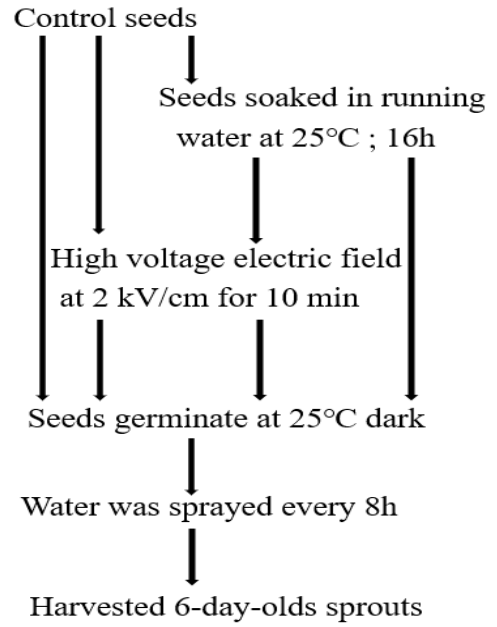
Figure 1. Procedure for seed treatments and production of adzuki bean sprouts.